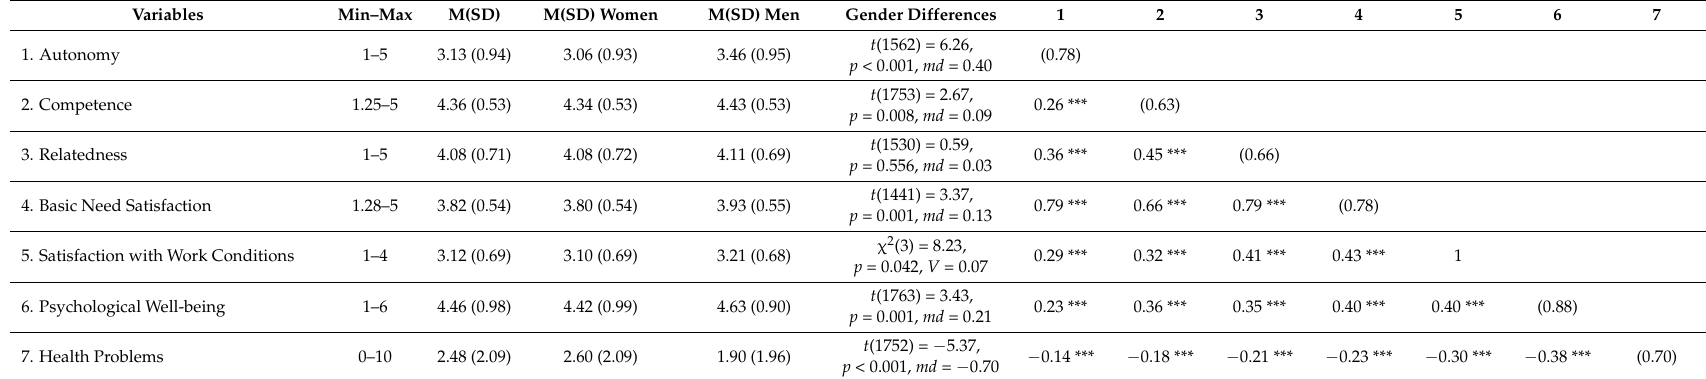
Table 2. Descriptive statistics, internal consistency reliability, gender differences, and correlation analyses among study variables in the total sample of health